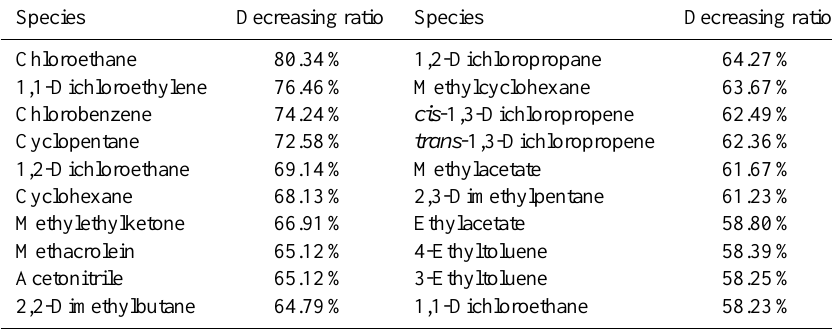
Table 3. The top 20 volatile organic compound (VOC) species with the highest decreasing ratios. Species Decreasing ratio